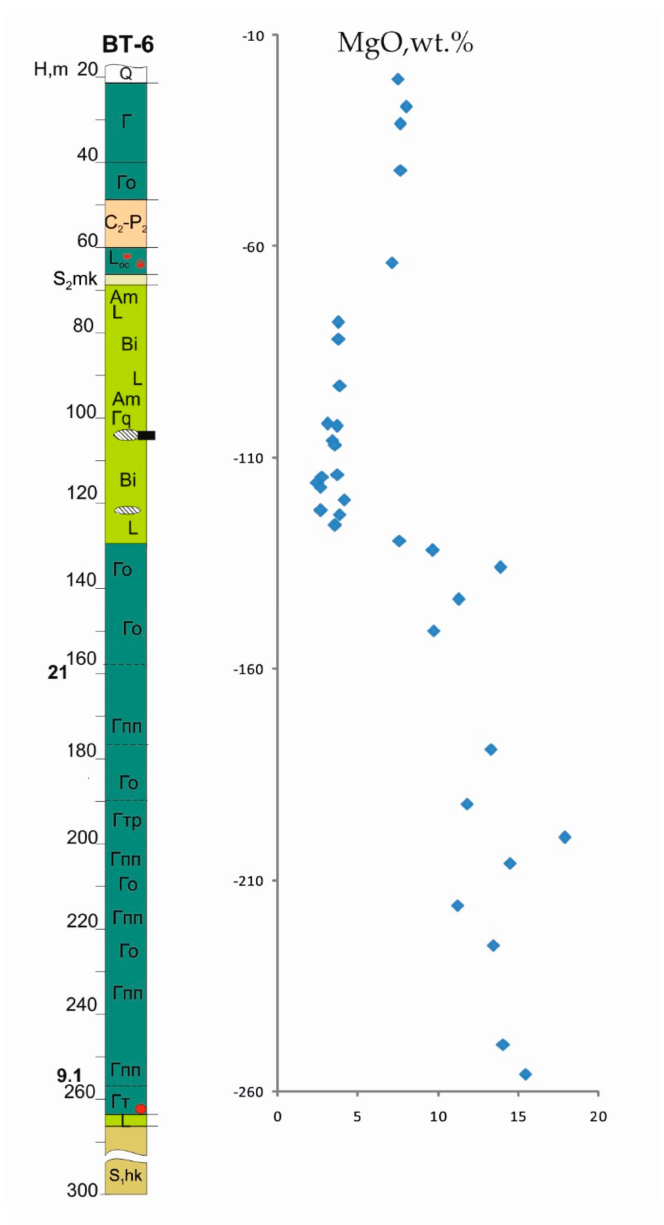
Figure 7. MgO (wt %) distribution along the borehole BT-6